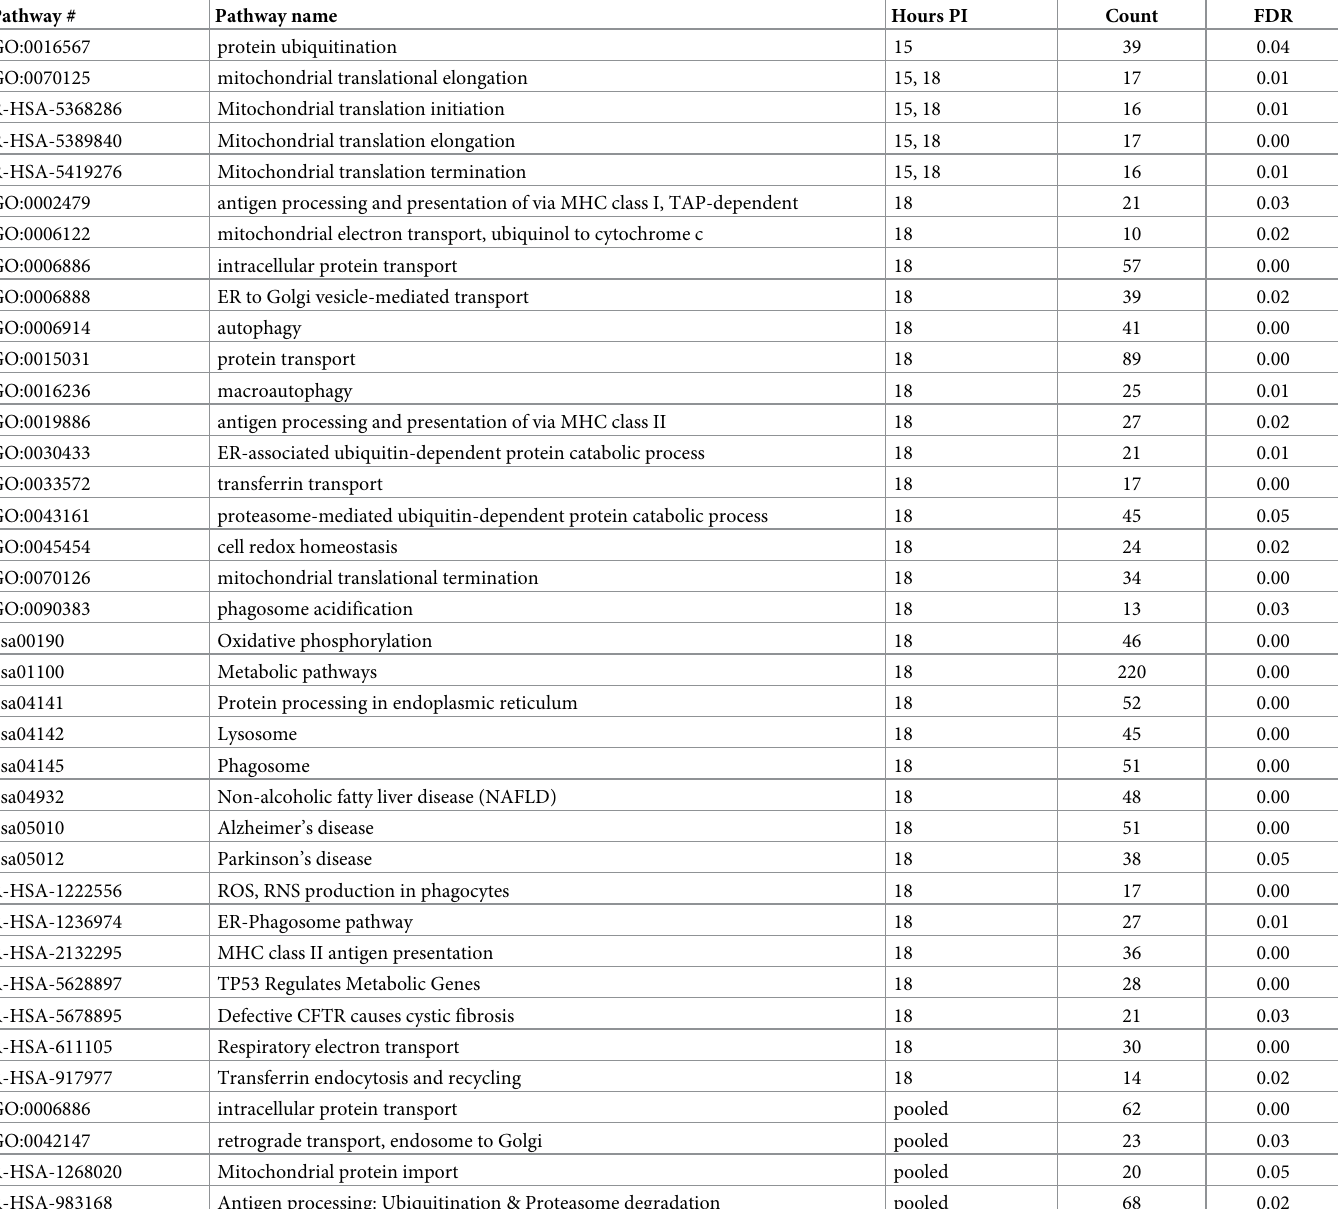
Table 4. Biological pathways with over-represented genes of 2340 significantly down-regulated genes using a web tool (DAVID Bioinformatics Resources 6.8) dur- ing the first 18 hours of infection. Pathway